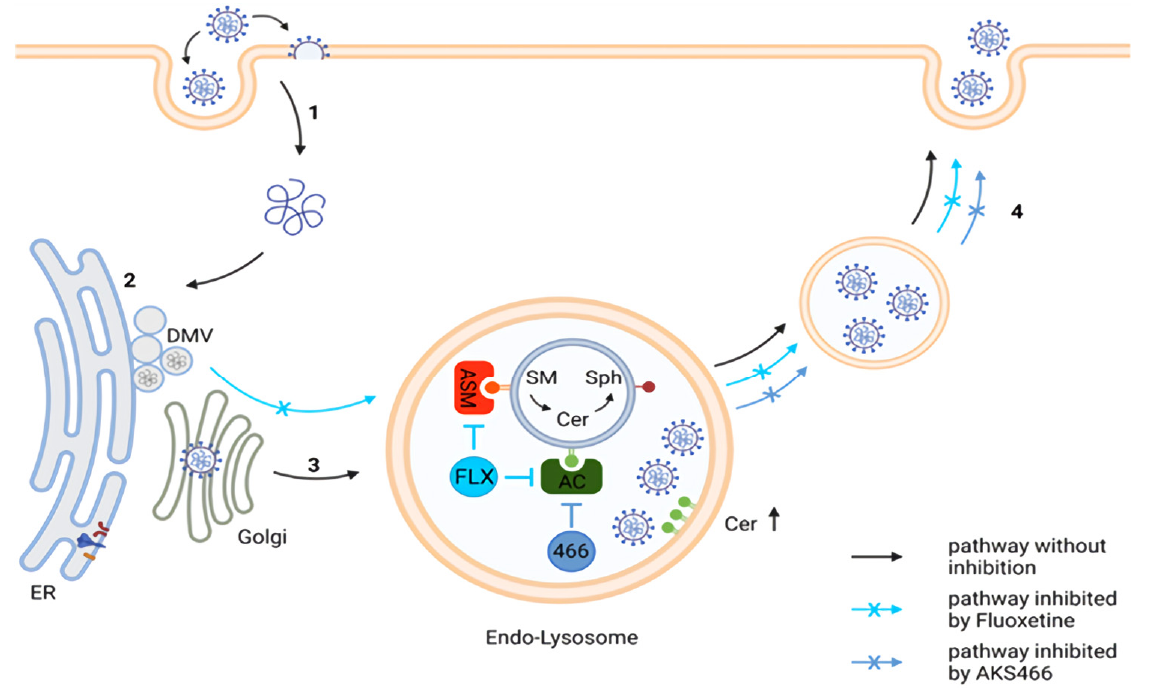
Figure 7. Suggested mechanisms of fluoxetine and AKS466 inhibition . ( 1 ) Viral entry by fusion pathway and release of viral RNA into the cytosol. ( 2 ) Viral replication and assembly. ( 3 ) Trans- port to endo-lysosomes: acid sphingomyelinase (ASM) acts at intra-luminal vesicles and degrades sphingomyelin (SM) to ceramide (Cer), which is further metabolized by acid ceramidase (AC) to sph- ingosine (Sph). Fluoxetine (FLX) inhibits ASM and AC, while AKS466 only inhibits AC. We suggest that inhibition of AC and ceramide accumulation leads to viral particle enrichment in endo-lysosomes and prevents release on the endo-lysosomal egress route ( 4